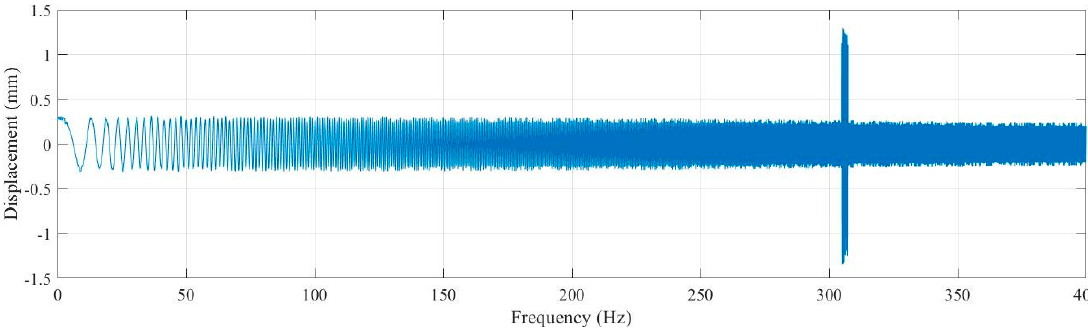
Figure 18. Displacement & Frequency.